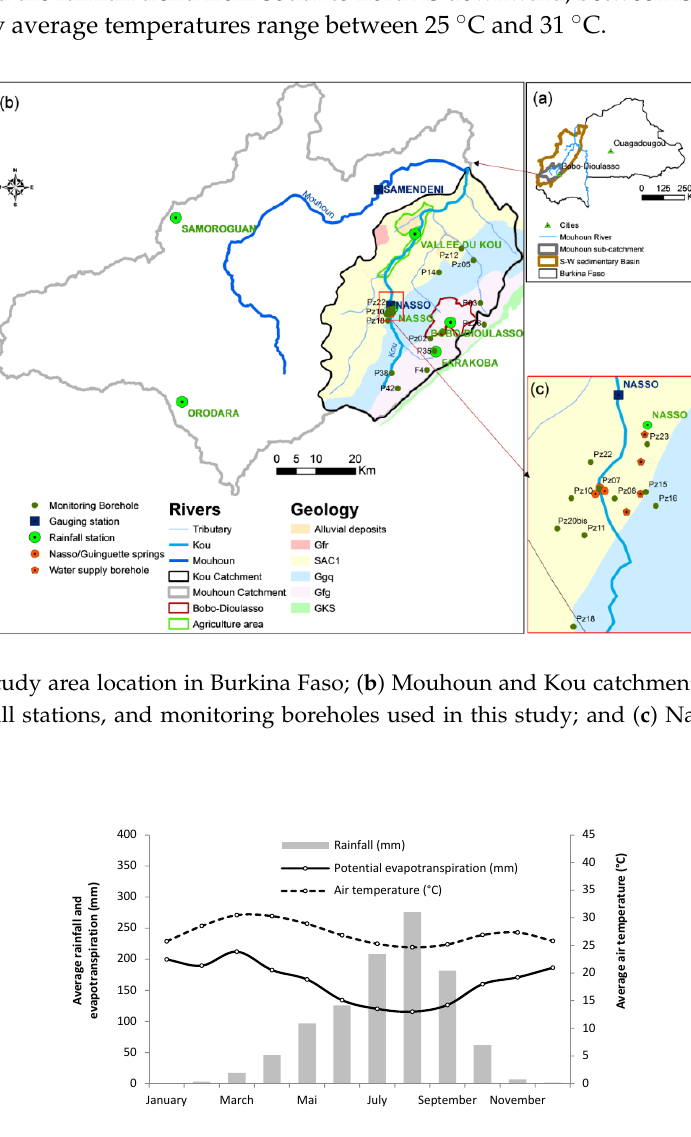
Figure 2. Monthly average rainfall, air temperature, and potential evapotranspiration from 1961 to 2014 at Bobo-Dioulasso station.